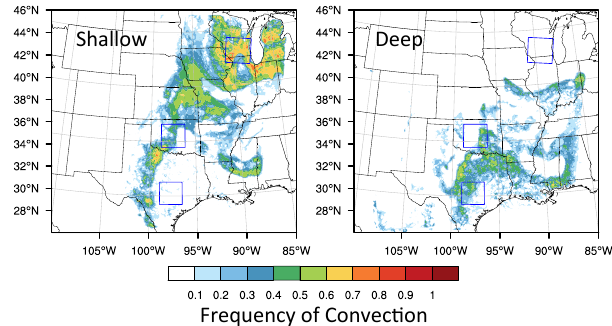
Figure 3. Frequency of occurrence of deep convection (right) and shallow convection (left) for the time period 12:00–20:00UTC on 25 June 2007. Boxes indicate sub-regions, 240km on a side, se- lected for